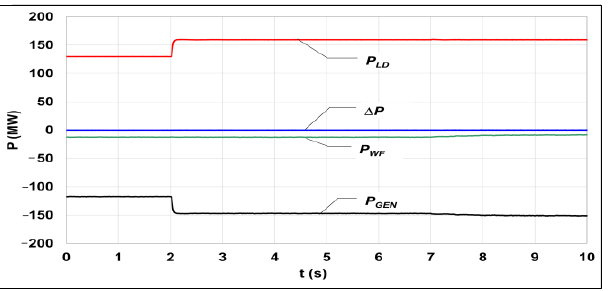
Figure 14. Changes in active power in the system, resulting from the farm operation in the voltage regulation mode (the symbols used correspond to those in Figure 8).